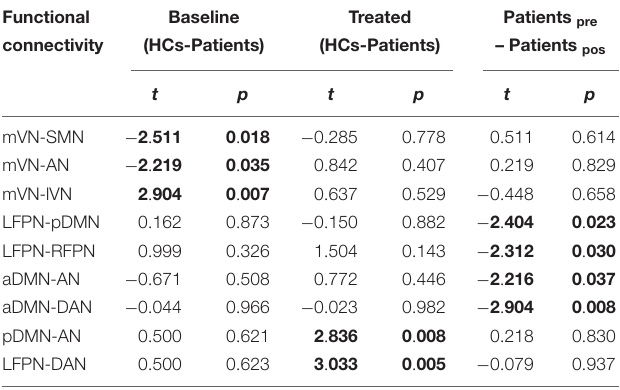
TABLE 3 | Intergroup differences in the inter-network functional connectivity. Functional Baseline Treated Patients